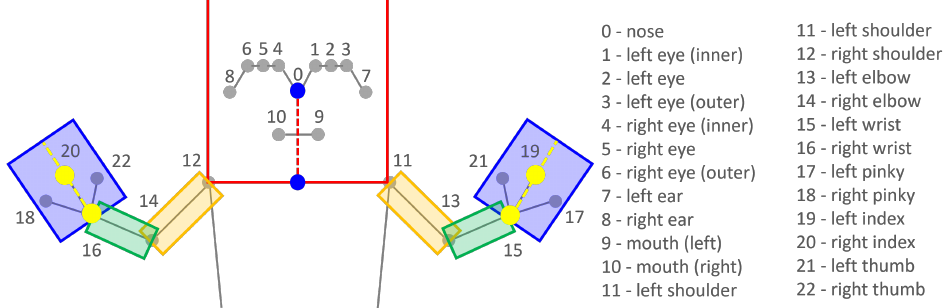
Figure 6. The upper arm range is represented by the orange box from the shoulder joint to the elbow joint and extending to both sides. The lower arm range is represented by the green box from the elbow joint to the index joint and extending to both sides. The hand range is represented by the blue box extending from the wrist joint along the index joint to the first pixel with an alpha value of